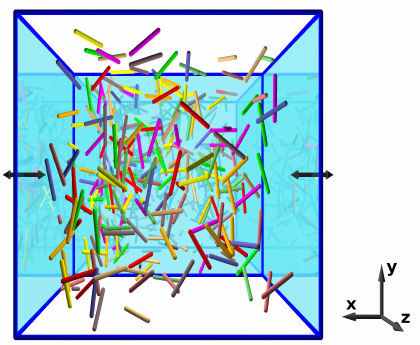
Figure 1. Dilute system of N = 256 spherocylinders with aspect ratio ζ = 9 . 2. The blue walls vibrate in their normal direction as described in the